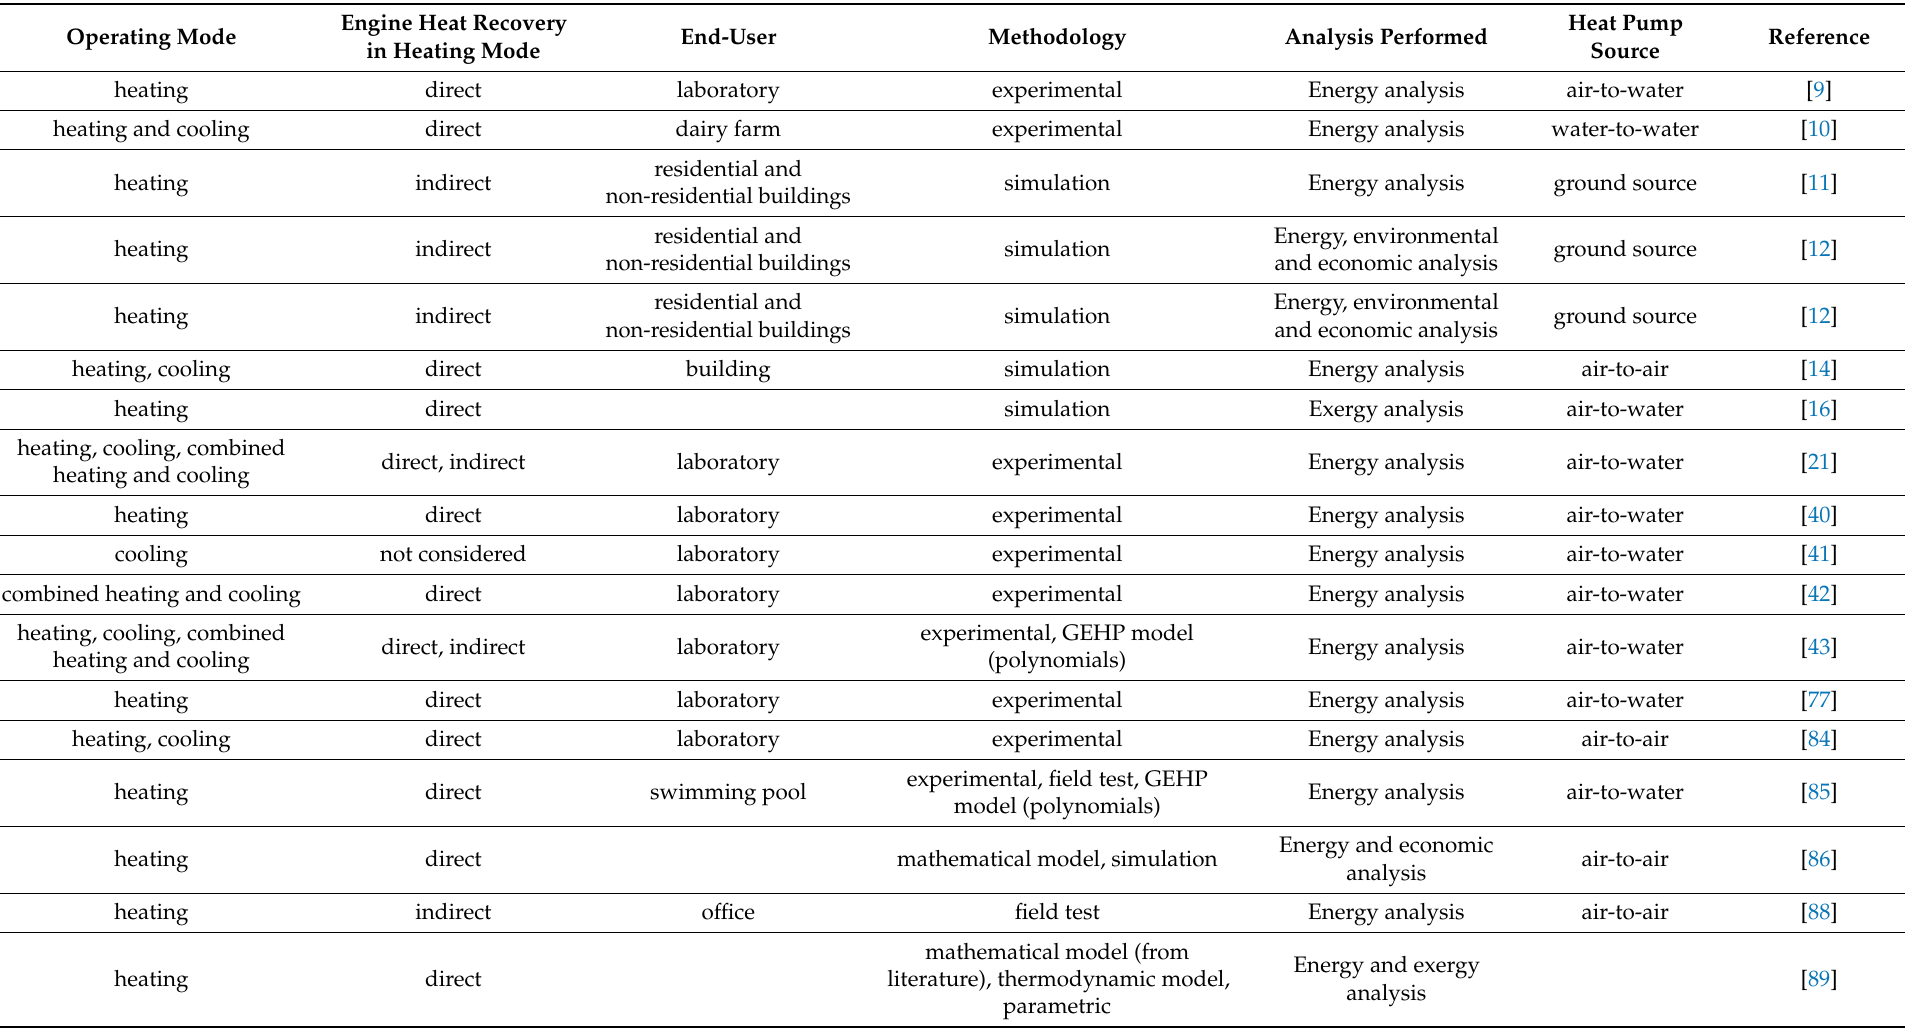
Table A4. Summary table for GEHPs without generator analysed in the